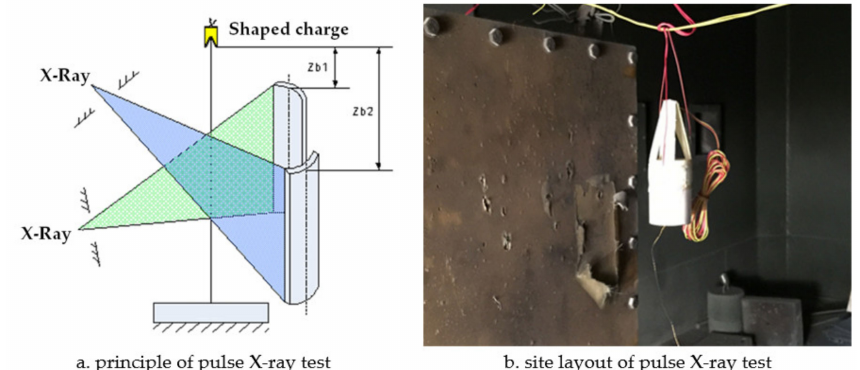
Figure 4. Test principle and test setup.